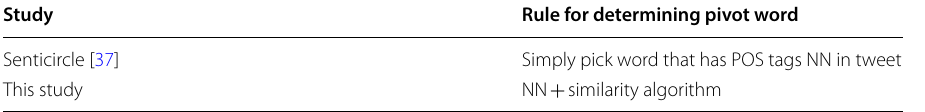
Table 10 Technique for determining pivot